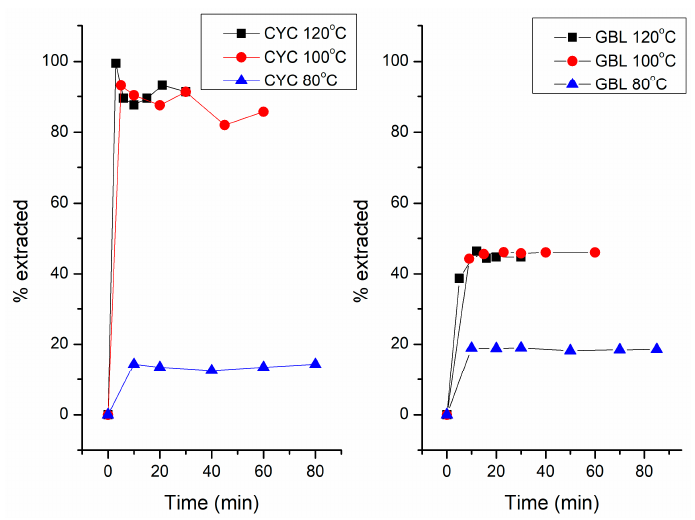
Figure 3. Extraction kinetics of PHA from cells using cyclohexanone (CYC, left ) and γ -butyrolactone (GBL, right ) at various temperatures.